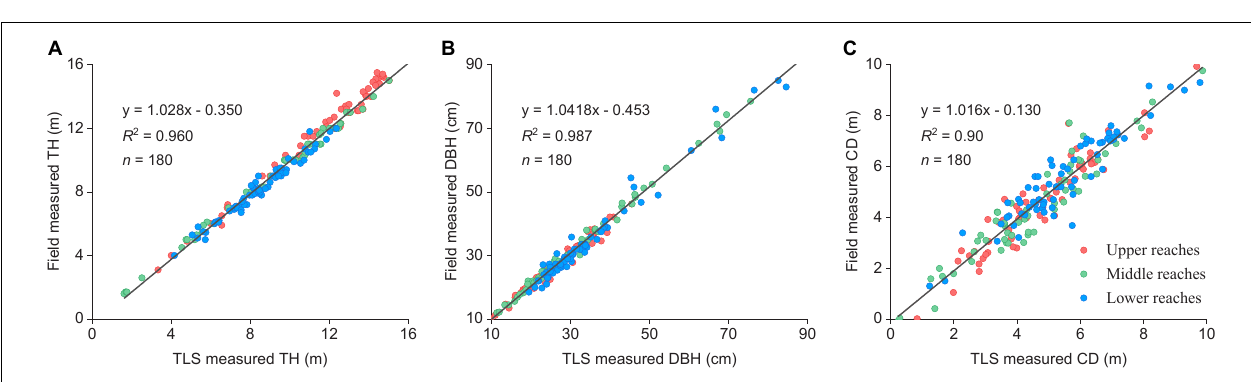
FIGURE 2 | (A) Schematic diagram of the TLS scanning layout, located at the center point and four corners of each plot. (B) Original TLS multi-station combined point cloud data of plot U5. The Change in color from blue to red indicates an increase in altitude. (C) Individual P. euphratica tree identification results which represented by different colors. (D) Individual tree point cloud data, where green points indicate tree. The highest green point indicates the tree height (TH) value, and the red circle is the position of the cross-section used to obtain the diameter at breast height (DBH) value.